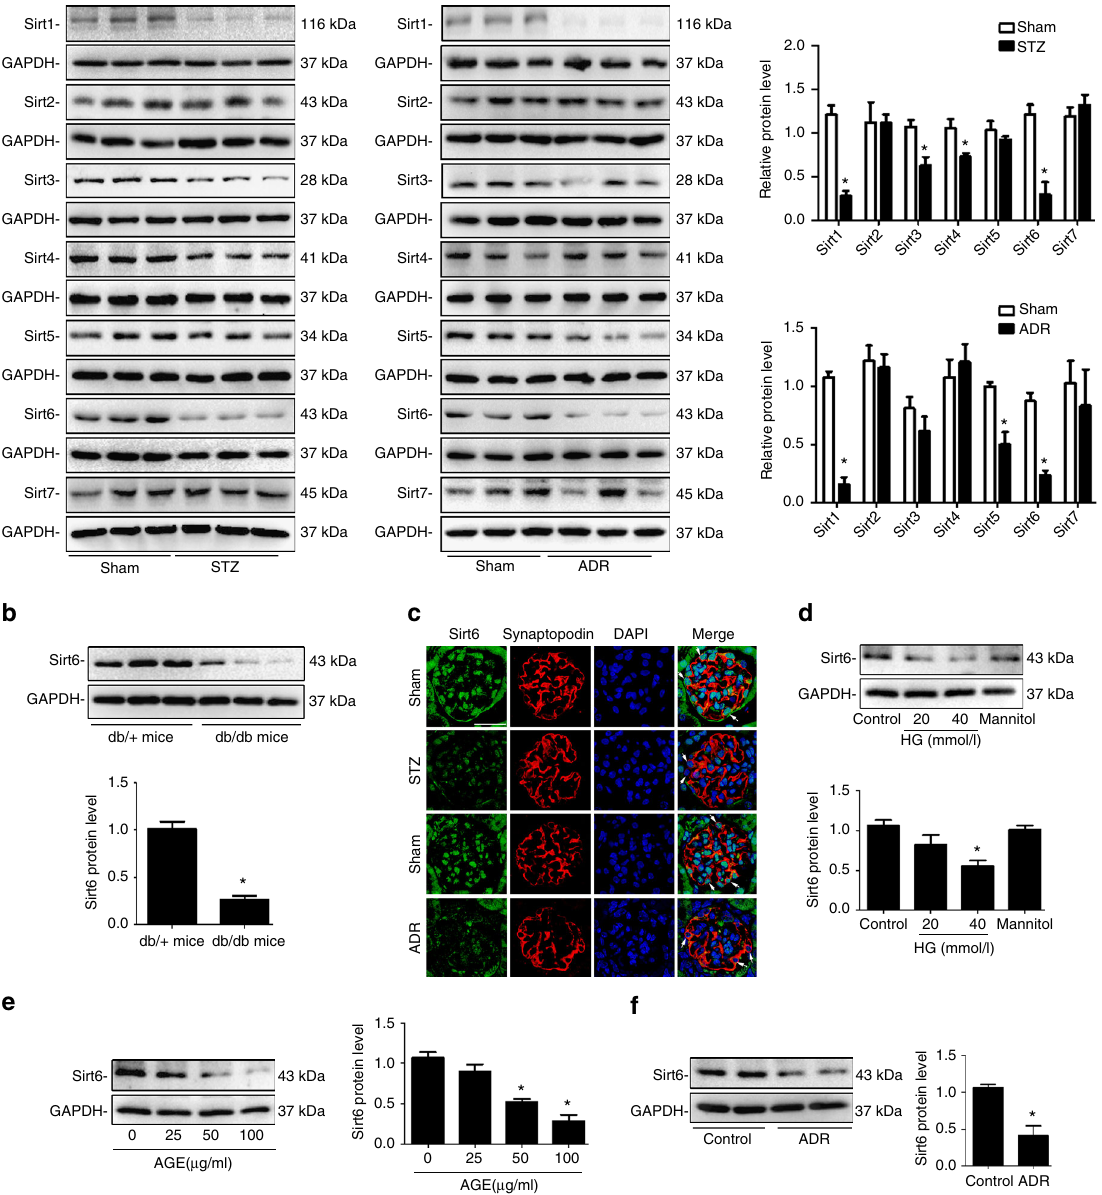
Fig. 1 Sirt6 is signi fi cantly reduced in podocytes from mice with diabetic nephropathy or ADR nephropathy. a Representative western blot gel documents and summarized data showing the relative protein levels of SIRTs in the kidney from STZ-induced diabetic mice and ADR-treated mice. * P < 0.05 vs. control mice. ( n = 8.) b Representative western blot gel documents and summarized data showing the relative protein levels of Sirt6 in the kidney from diabetic db/db mice and their genetic control db/ + mice. * P < 0.05 vs. db/ + mice. ( n = 8.) c Representative confocal microscopic images showing the expression of Sirt6 in podocytes from STZ-induced diabetic mice and ADR-treated mice, synaptopodin were used as podocyte marker. The arrows indicate representative podocytes. Scale bar , 25 μ m. d Representative western blot gel documents and summarized data showing the relative protein levels of Sirt6 in podocytes treated with high glucose (HG, fi nal concentration 20 or 40 mmol/l in medium) for 24h. * P < 0.05 vs. control. ( n = 6.) e Representative western blot gel documents and summarized data showing the relative protein levels of Sirt6 in podocytes with advanced glycation end-product (AGE, 50 – 200 μ g/ml) for 24h. * P < 0.05 vs. control. ( n = 6.) f Representative western blot gel documents and summarized data showing the relative protein levels of Sirt6 in podocytes with ADR (ADR, 0.4 μ g/ml) for 24h. * P < 0.05 vs. control. ( n = 6.) Data are expressed as means ± SE. Student ’ s t -test was employed for comparisons between two groups; one-way ANOVA followed by Tukey ’ s post-test for multiple comparisons was used for groups of three or